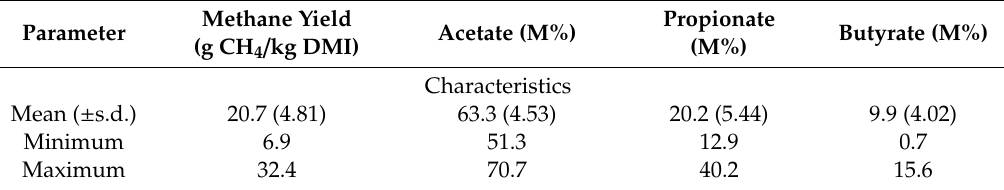
Table 3. Summary of data used to develop models between methane yield and individual volatile fatty